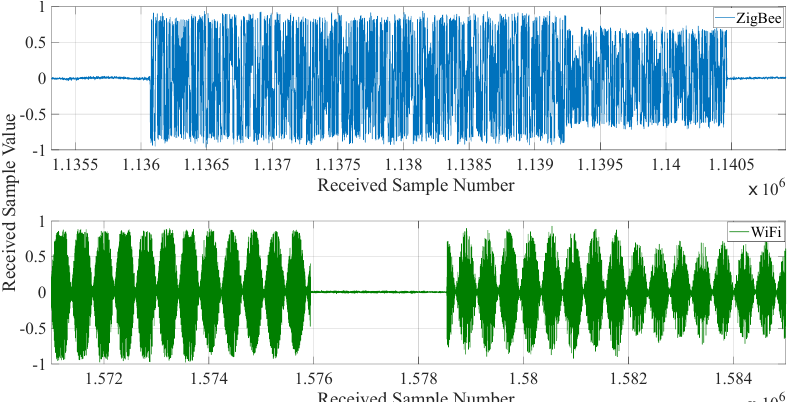
Figure 5. Example time series representations of received wireless signals on the I-channel, which establishes the need for correct sample